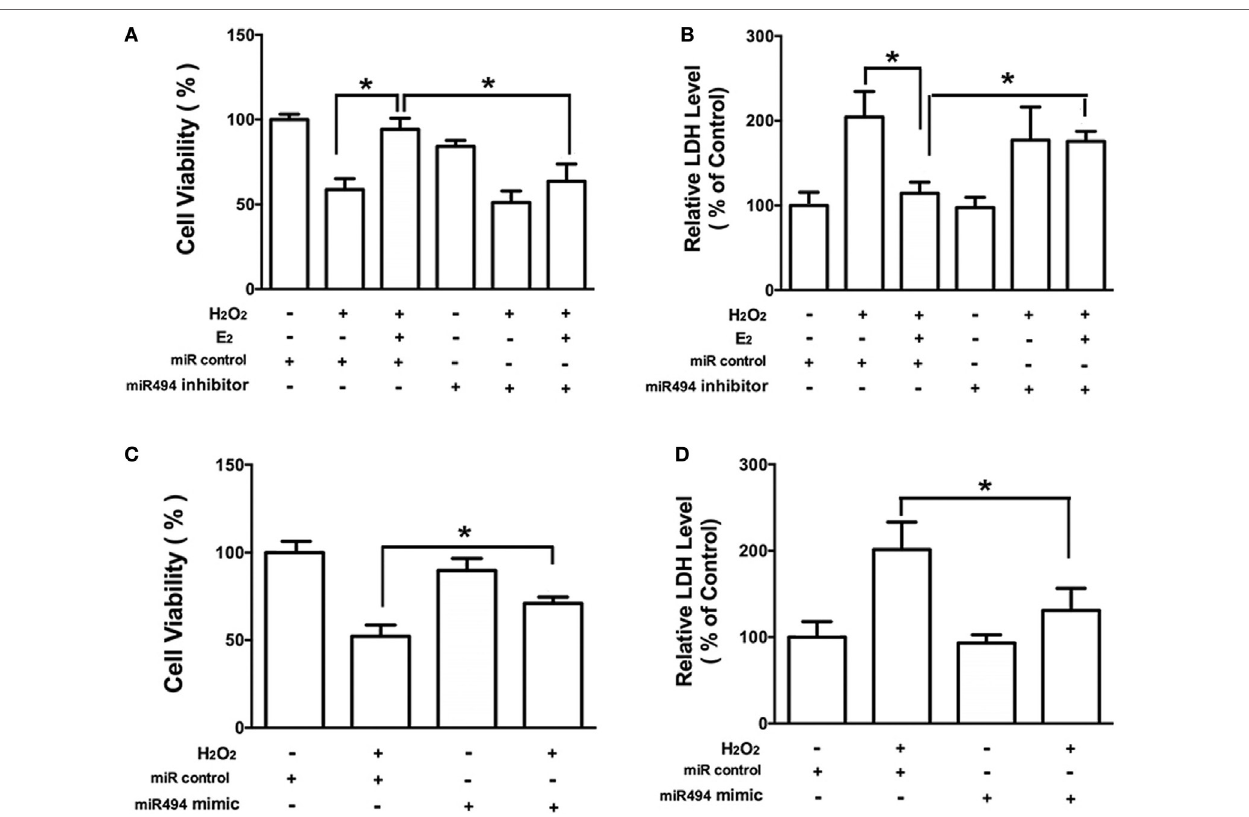
FigUre 3 | miR-494 contributes to the protective effects of E 2 against oxidative stress in cardiomyocytes. (a,B) H9c2 cells were transfected with control microRNA (miR) or miR-494 inhibitor for 24 h and then treated with E 2 (10 nmol/L) for another 24 h. Cells were then exposed to H 2 O 2 (200 µmol/L) for 4 h. Overall cell viability was assessed by MTT (a) and supernatant lactate dehydrogenase (LDH) concentration (B) . (c,D) H9c2 cells were transfected with control miR or miR-494 mimics for 24 h. Cells were then exposed to H 2 O 2 (200 µmol/L) for 4 h. Overall cell viability was assessed by MTT (c) and supernatant LDH concentration (D) . All bar graphs represent the means ± SEM from four independent experiments. * P <